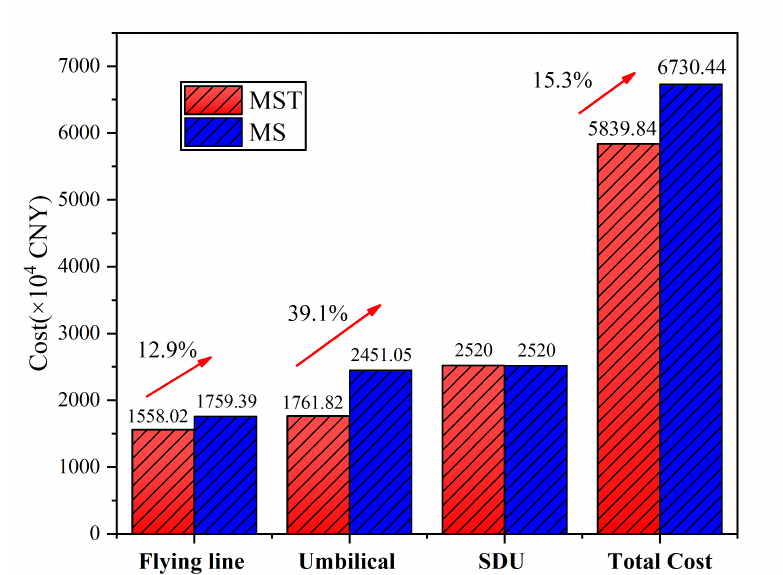
Figure 9. Overall comparison of the optimization results for the two layout structures.